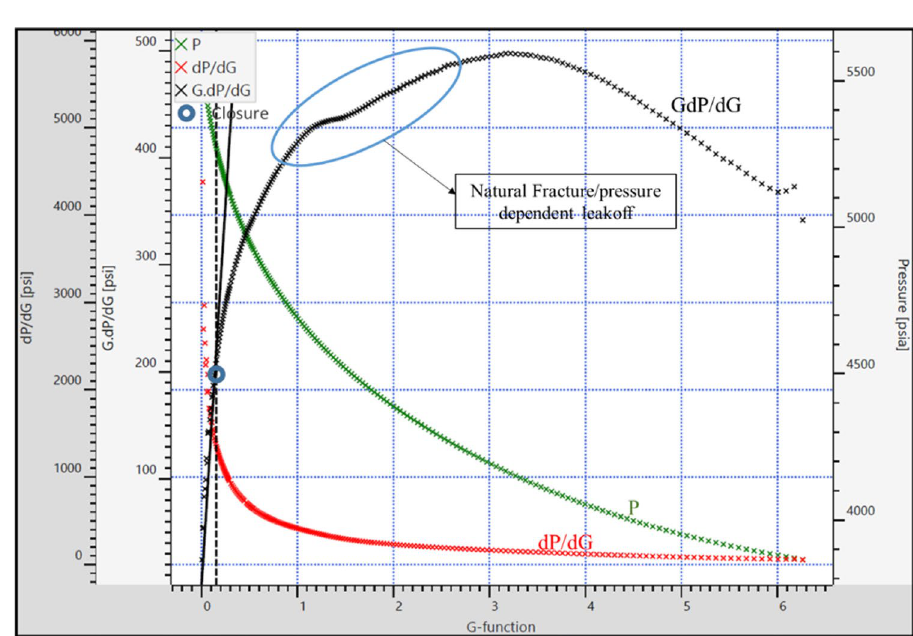
Fig. 10 A G-function plot for Cycle #4. Natural fracture- dependent leakoff (NFL) behavior happened after appar- ent